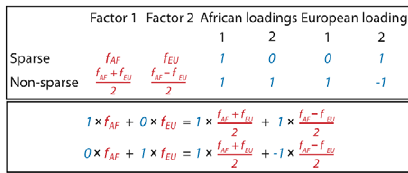
Figure 2. Illustration of two different ways that African and European individuals could be represented. In the first (sparse) representation in the first row, the factors (shown in red) each represent the mean allele frequencies for either the African population ( f AF ) or the European population ( f EU ); this lends to sparse loadings (shown in blue) for each individual, since the African individuals are only loaded on the factor representing the African population, and likewise for the European individuals. In the second (non-sparse) representation in the second row, each factor is a combination of f AF and f EU , and each individual is loaded onto both factors. Note that the representations are equivalent by the equations under the table. Whereas SFA and admixture-based models tend to choose the first representation because of the sparse priors and implicit regularization, PCA tends towards the second representation (although the actual factors depend on other features of the data such as sample sizes of both groups).